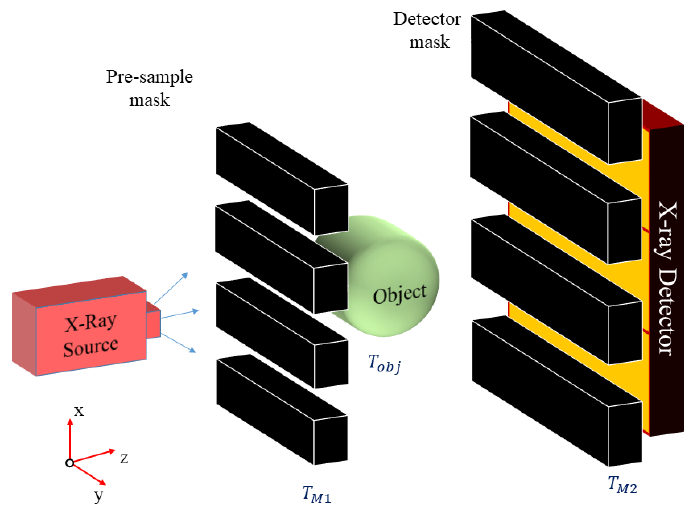
Figure 1. Components and geometry of the EI-XPCi (as well as PB-XPCi) system